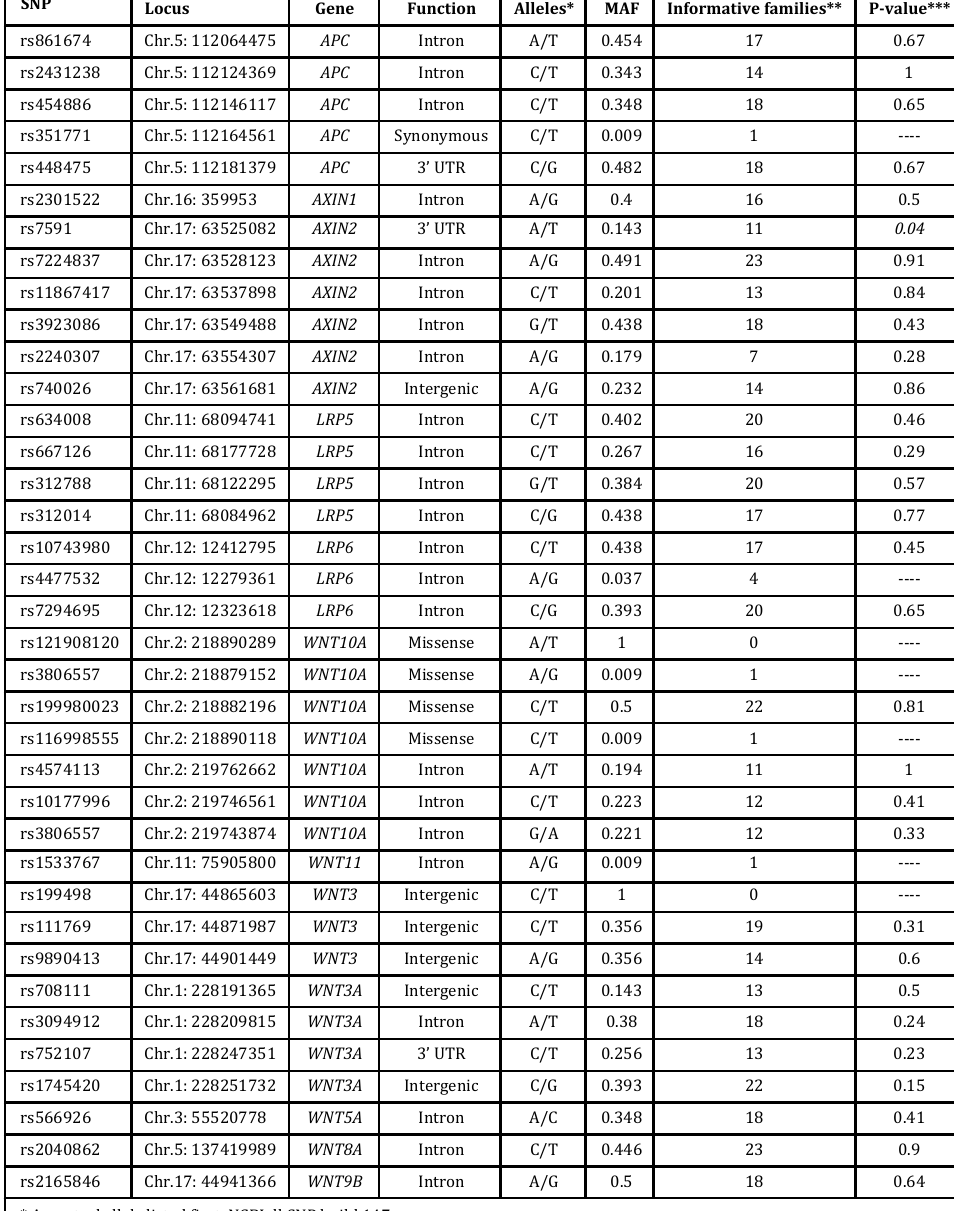
Table&2.& Details(of & SNPs(genotyped(in(this(study(and(association(results.( SNP& Locus& Gene&